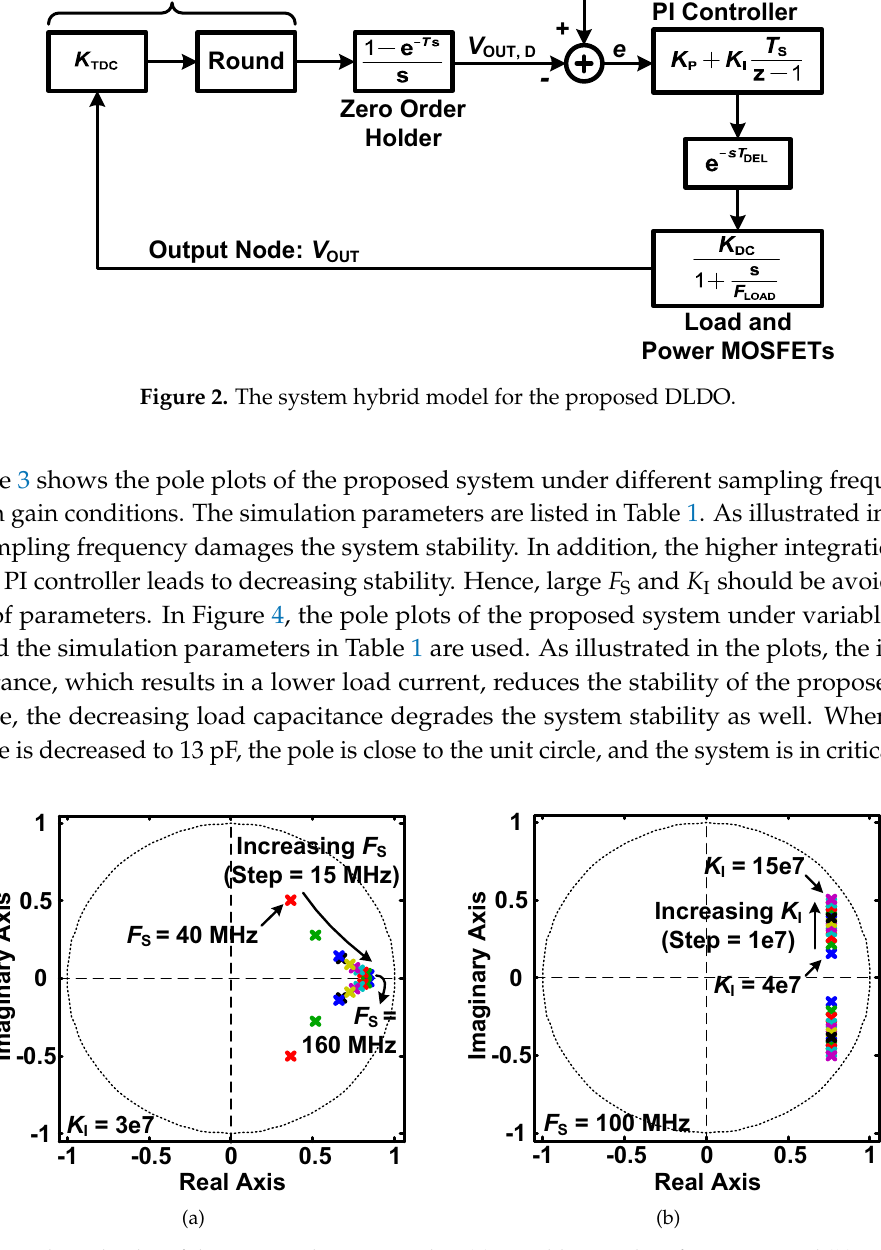
Figure 3. The pole plot of the proposed system under: ( a ) variable sampling frequency; and ( b ) variable integration gain. Table 1. The simulation parameters of the system hybrid